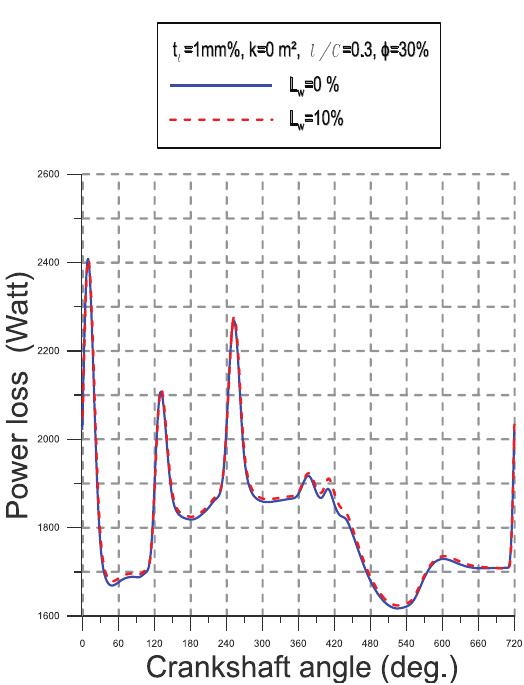
Fig. 14. Effects of dynamic misalignment on power loss over an entire